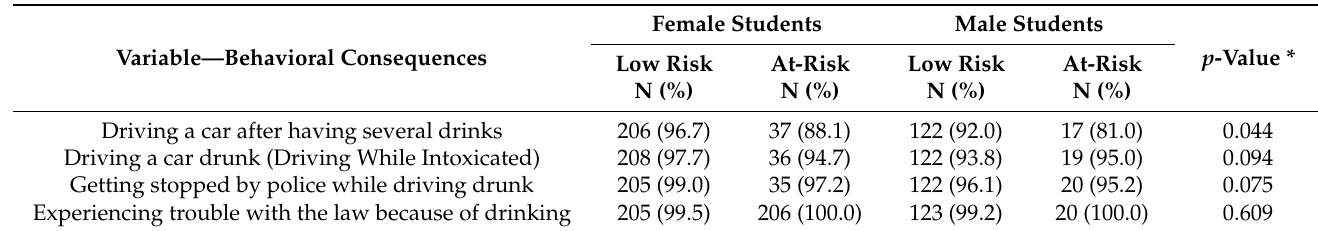
Table 4. Problems related to driving after drinking and problems with authorities.